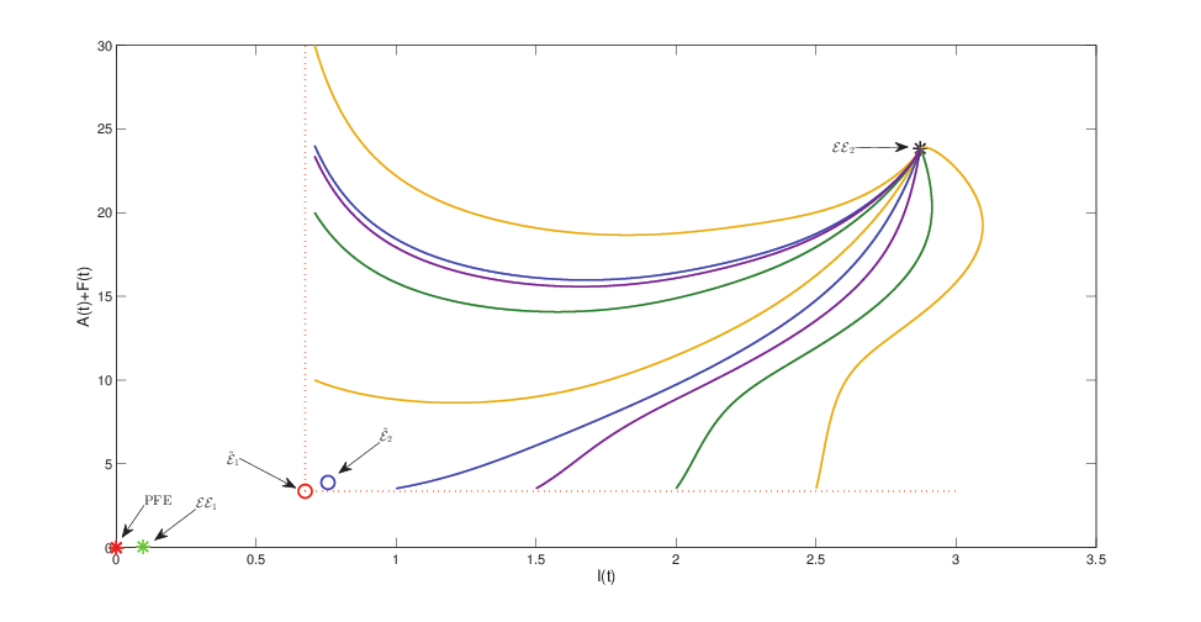
Fig. 6. Illustration of persistence of the infection as proven in Theorem 3. Observe that solutions of model (1) originating at the level of ˜ E 1 remain non-zero for all